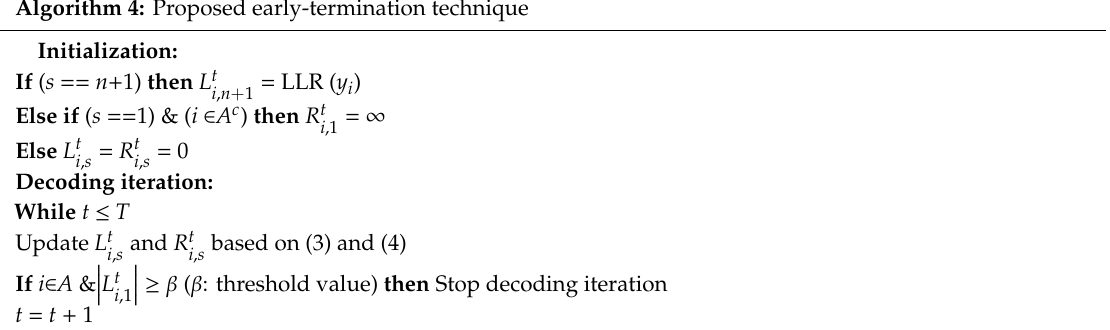
Algorithm 4: Proposed early-termination